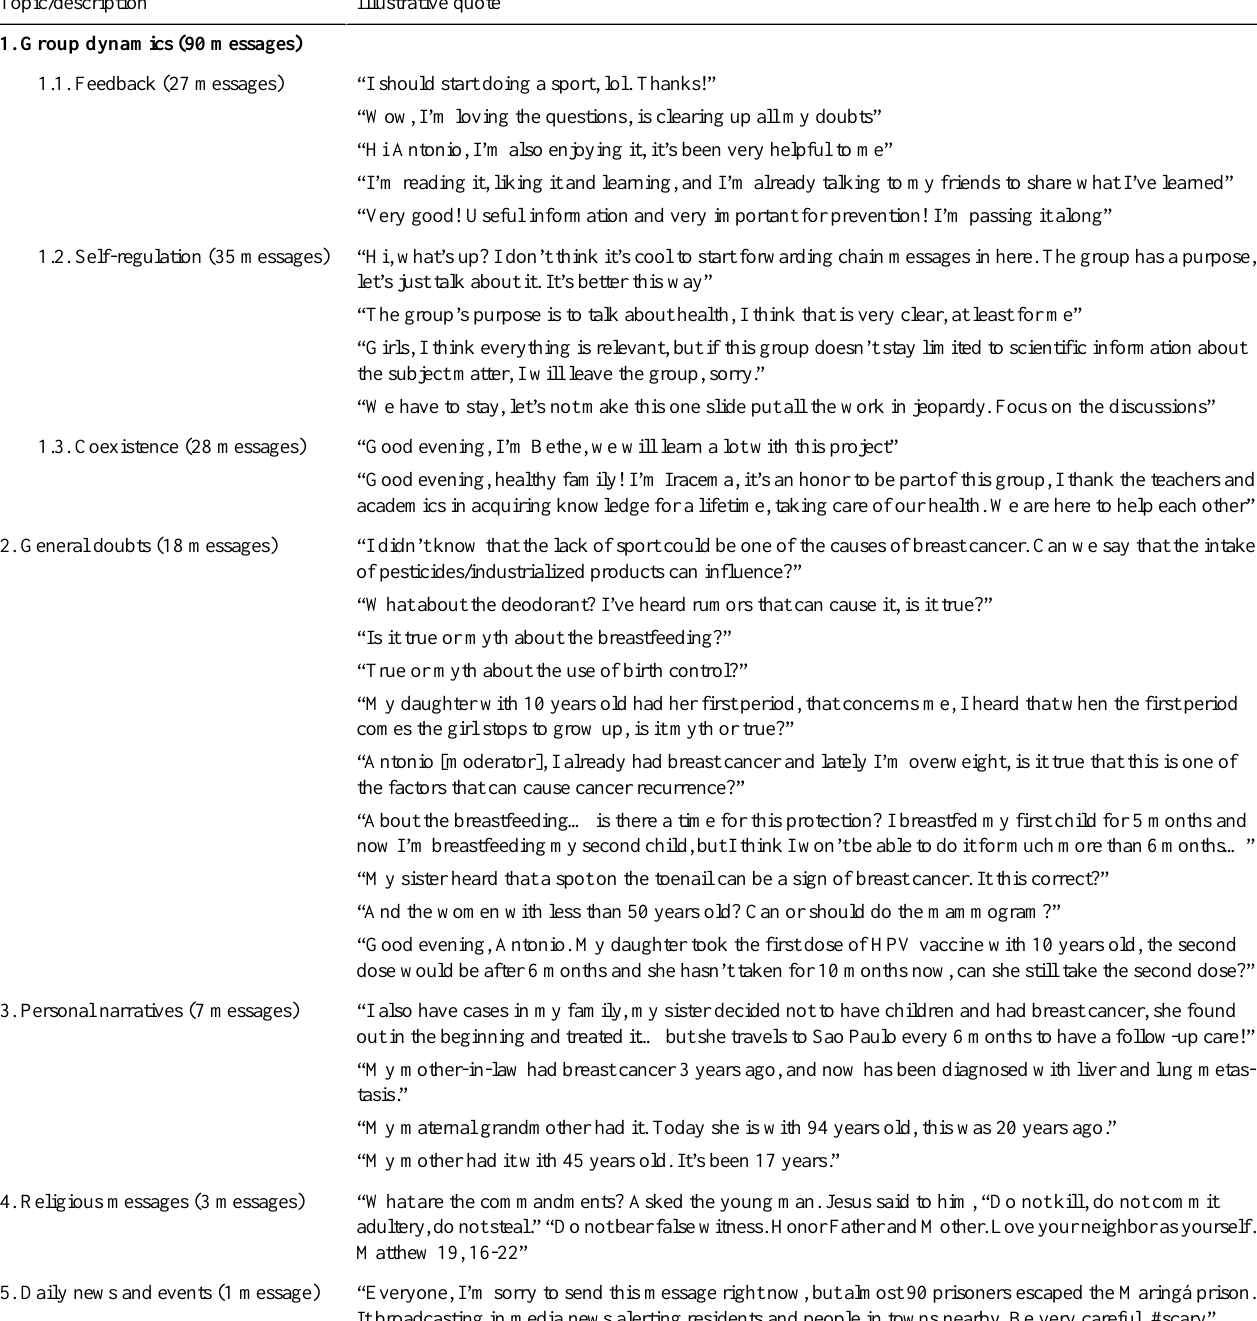
Table 1. Thematic categories (translated from Portuguese to English). Illustrative